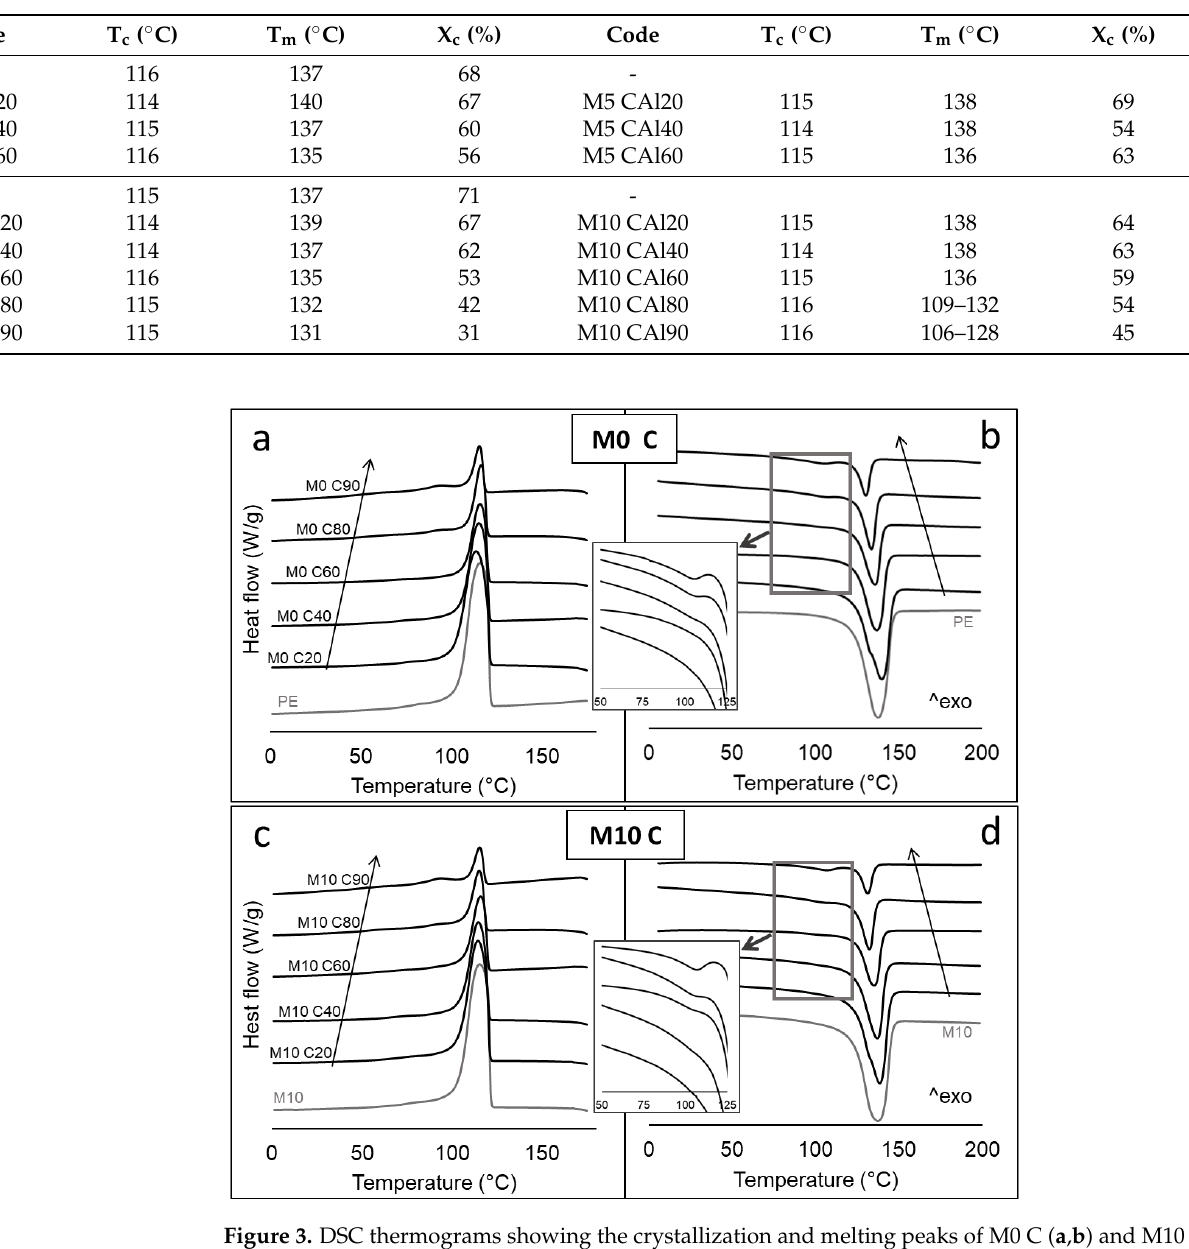
Figure 3. DSC thermograms showing the crystallization and melting peaks of M0 C ( a , b ) and M10 C ( c , d ) systems, respectively. Arrows indicate increasing MC